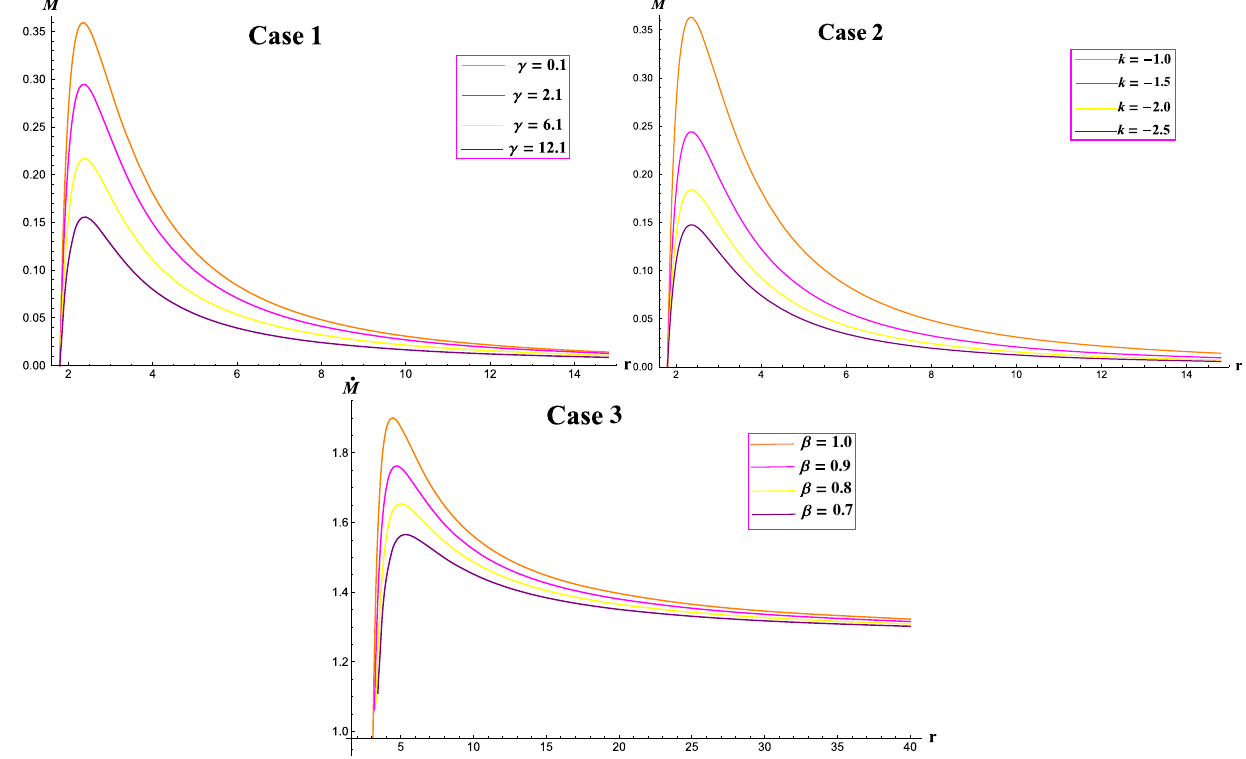
k = − 1, β = 1. Bottom panel (Schwarzschild BH) displays the behav- ior of Eq. (73) for Schwarzschild BH parameters γ = 0, k = 0, β = 1. Other constants are taken as L 0 = 0 . 90, L 1 = 0 .